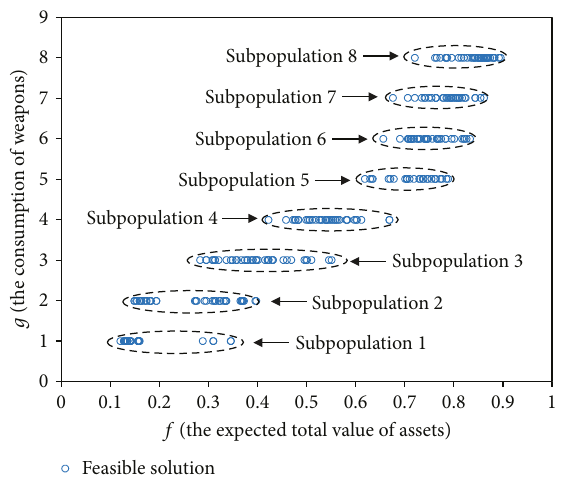
Figure 4: An illustration of the proposed decomposition